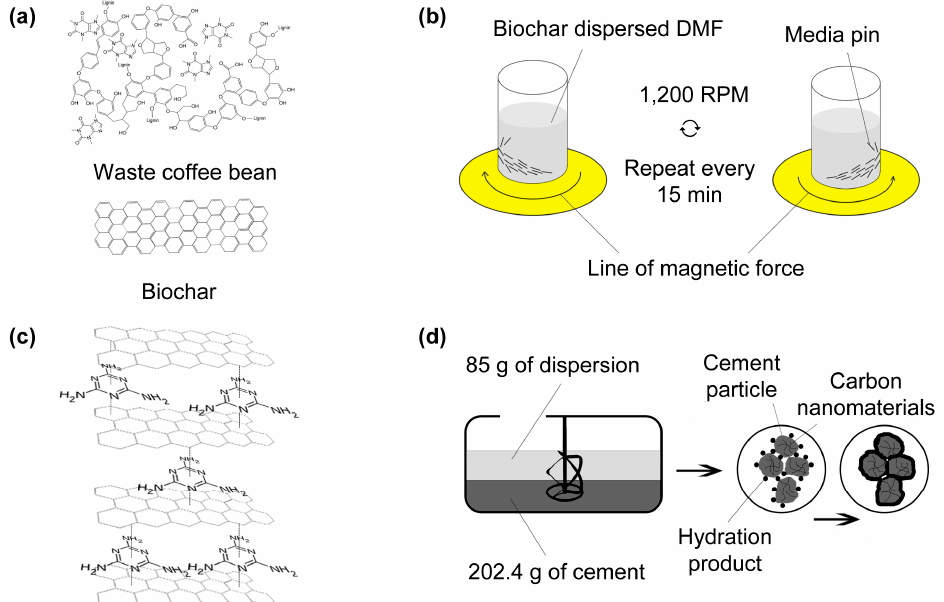
Figure 1. Synthesis and functionalization of biochar: ( a ) chemical structure of coffee waste and its structural transformation to conductive biochar; ( b ) schematic of the electromagnetic process; ( c ) functionalization of biochar by melamine; and ( d ) fabrication of m-biochar-reinforced cementi- tious